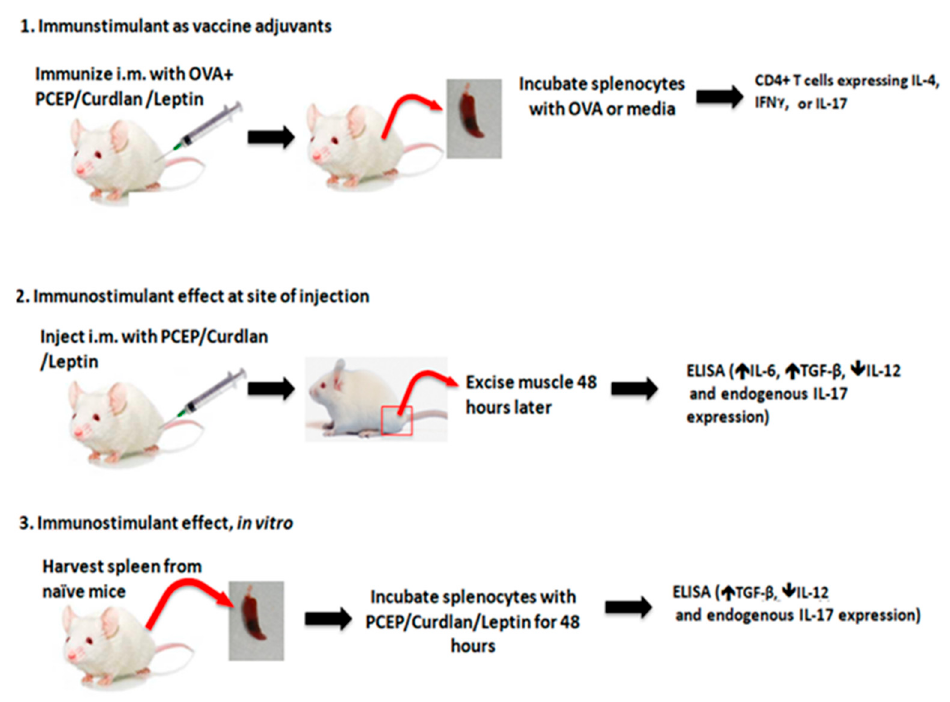
Figure 1. Schematic of experimentation: 1. Mice were immunized via the intramuscular route with OVA plus adjuvants, then splenocytes were excised and recall cell-mediated immune response was measured by cytokine production and an increase in CD4+ T cells expressing IL-4, IL-17, or IFN γ . 2. Mice were injected with immunostimulants into the thigh muscle. Two days later, muscles were isolated and production of IL-6, IL-12, IL-17, and TGF β was measured. 3. Spleens from naïve mice were isolated then stimulated with the adjuvant(s) ex vivo for 48 h. The cytokines produced in the supernatants were measure by ELISA.